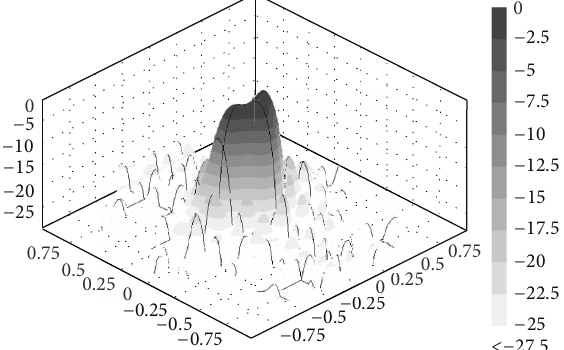
Figure 11: Simulated 𝐸 -plane far field of the 8 × 8 array with a circular radiation pattern.